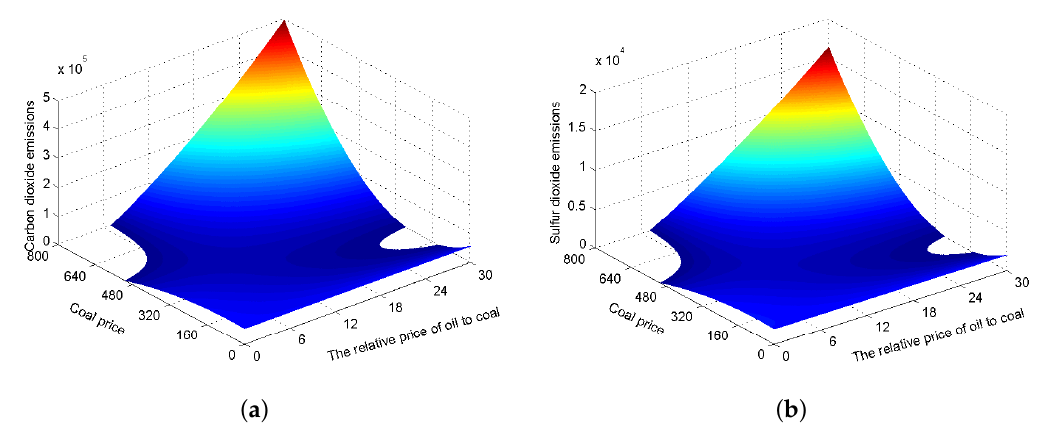
Figure 3. ( a ) The three-dimensional graph of W 1 , P 1 , and α ; ( b ) The three-dimensional graph of W 2 , P 1 , and α